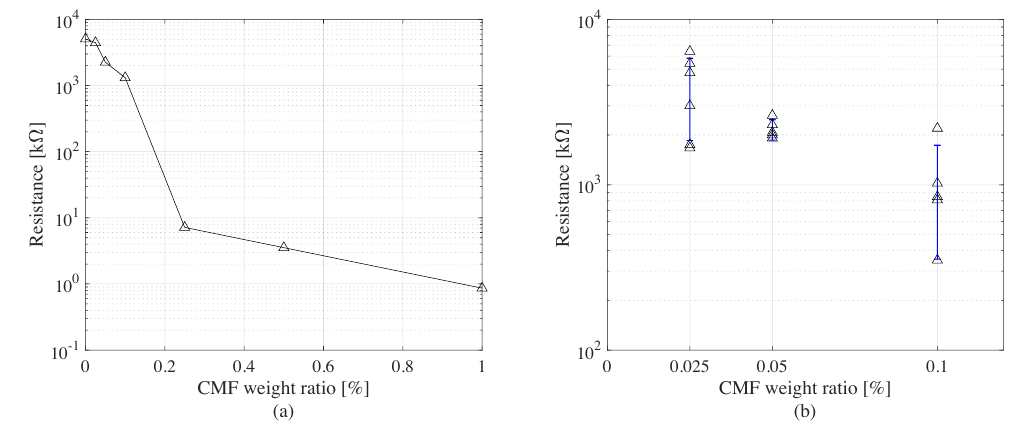
Figure 5. Electrical resistance readings of cube samples: ( a ) electrical resistance values of the sample set ranging 0–1% CMF doping ratios; ( b ) electrical resistance values of additional samples of critical CMF doping levels of 0.025–0.05–0.1% doping ratios, plotted with mean value and standard